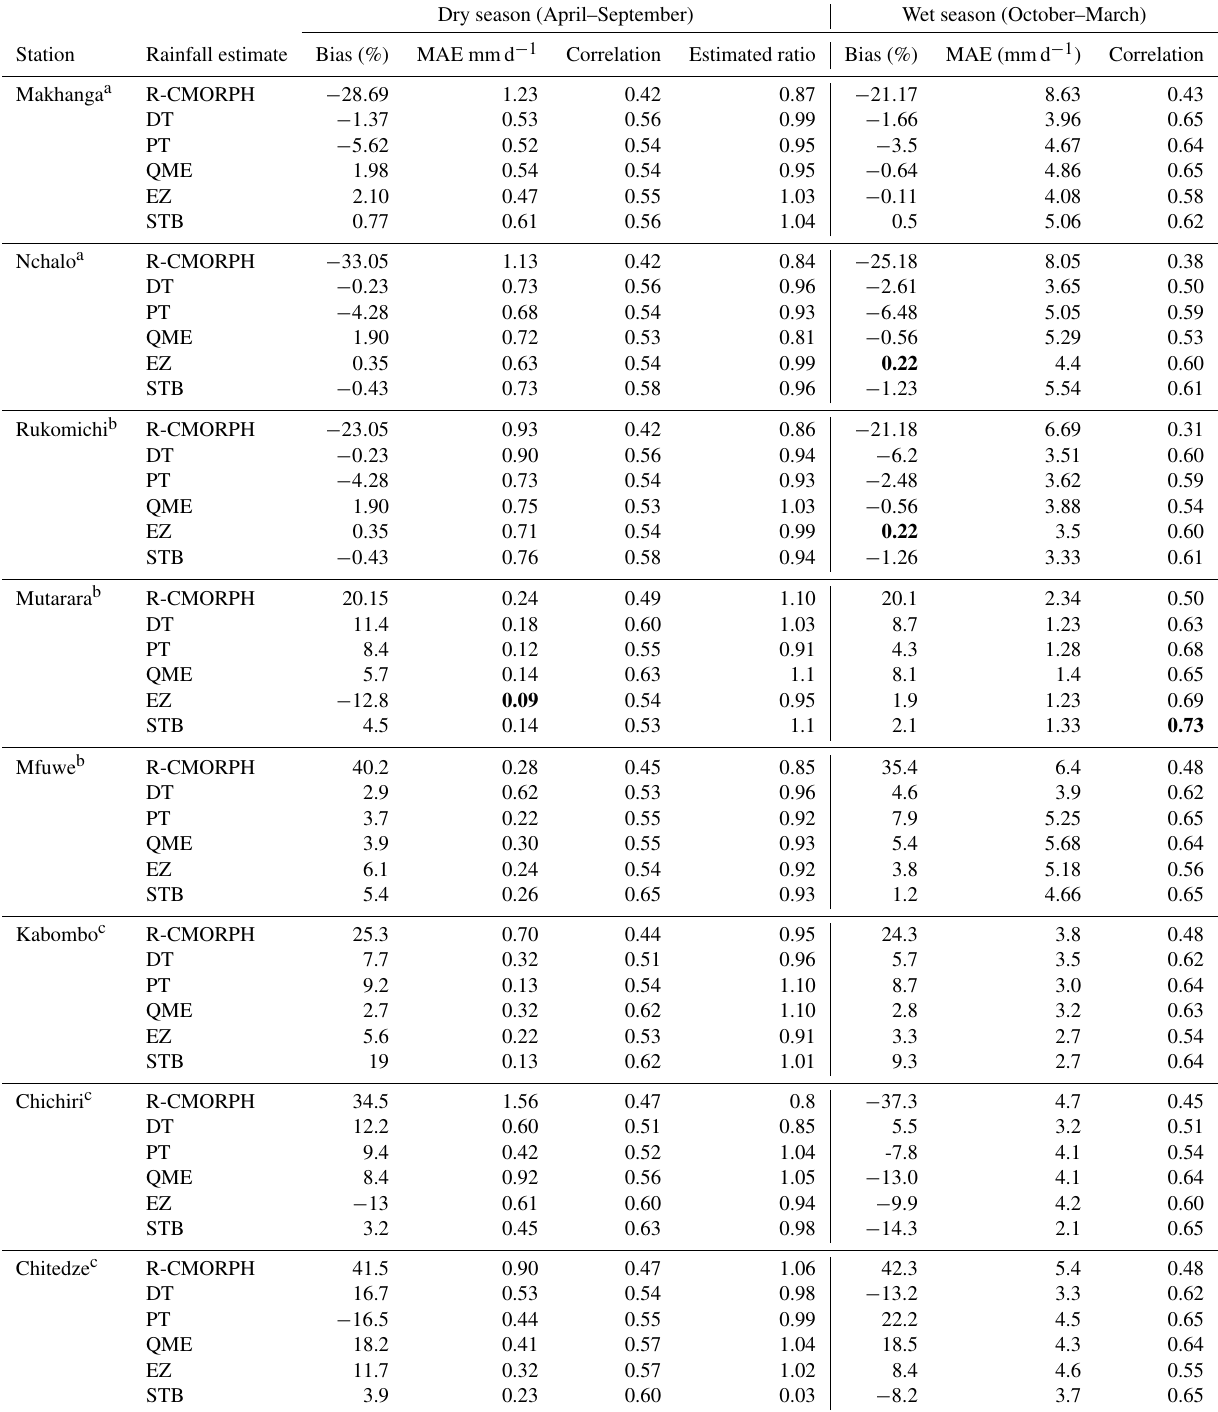
Table 4. Cross-validation results for the bias-correction procedure with eight gauging stations for the dry and wet seasons. Stations lie in an average elevation zone and are sort of centred in an elevation zone. R-CMORPH is the uncorrected R-CMOPRPH estimate. DT, PT, QME, EZ, and STB are the bias-corrected rainfall estimate. Bold values indicate best performance. a Zone 1: elevation of < 250m; b zone 2: elevation range of 250–950m; and c zone 3: elevation >